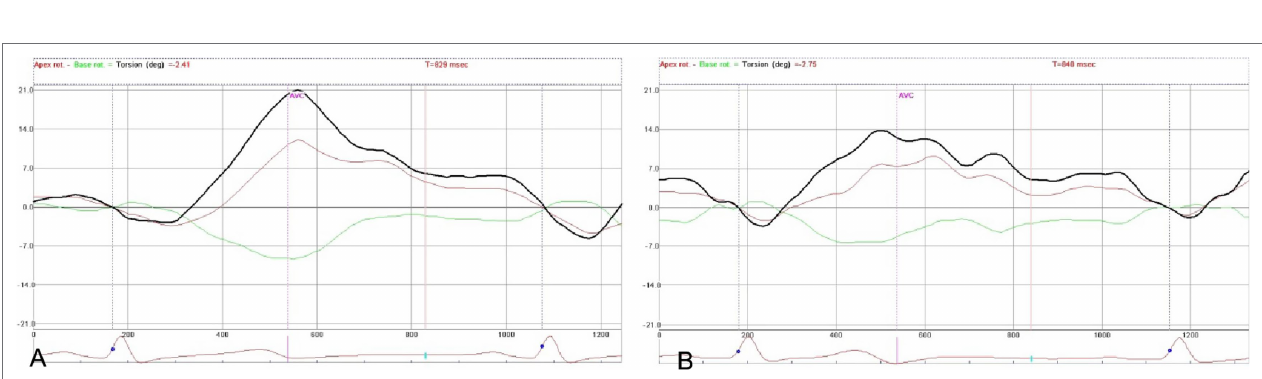
Data given as the mean ± SD. GLS, global longitudinal strain; GRS, global radial strain; GCS, global circular strain; Ptw, peak twisting; PTV, peak twisting velocity; PUV, peak untwisting velocity; TPTV, time peak twisting velocity; TPUV, time peak untwisting velocity; UntwR, untwisting rate.